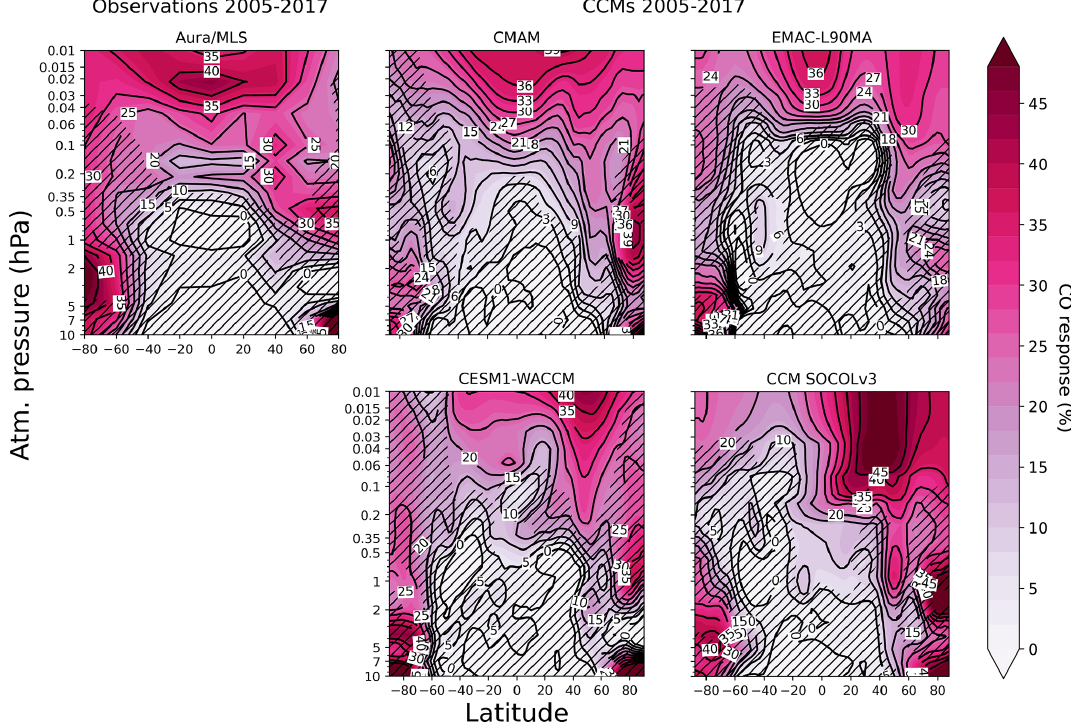
Figure 7. The relative importance of the solar signal in CO from CCMI-1 models and Aura/MLS for the 2005–2017 period presented as a percentage of the mean. Model and observation names are indicated at the top of each panel. Inclined hatches are areas with statistical significance less than 95%.